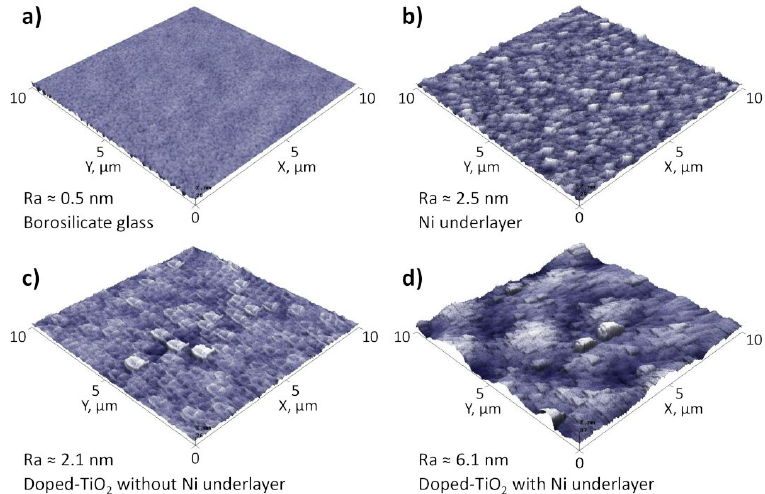
Fig. 4. 3D AFM surface images: a) uncovered borosilicate glass; b) Ni film on borosilicate glass; c) carbon-doped TiO 2 film deposited directly on borosilicate glass substrate; d) carbon-doped TiO 2 film deposited on Ni